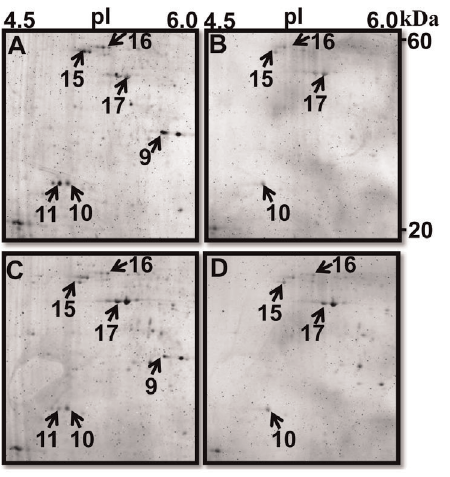
Figure 7. Close-up images of phosphorylated and depho- sphorylated spots. 300 m g Proteins of 3–4 segmented early larvae were incubated without (A) or with (B) 400 U l -PPase and separated by 2-DE (pH range 4–7). The upper and lower rows show the spot pattern in the absence (A and C) or presence (B and D) of l -phosphatase. Phosphorylated proteins (arrow heads) were detected by Pro-Q Diamond phosphoprotein stain (A and B) and SYPRO Ruby total protein stain (C and D). Spot numbers are corresponding to proteins listed in Table 1.